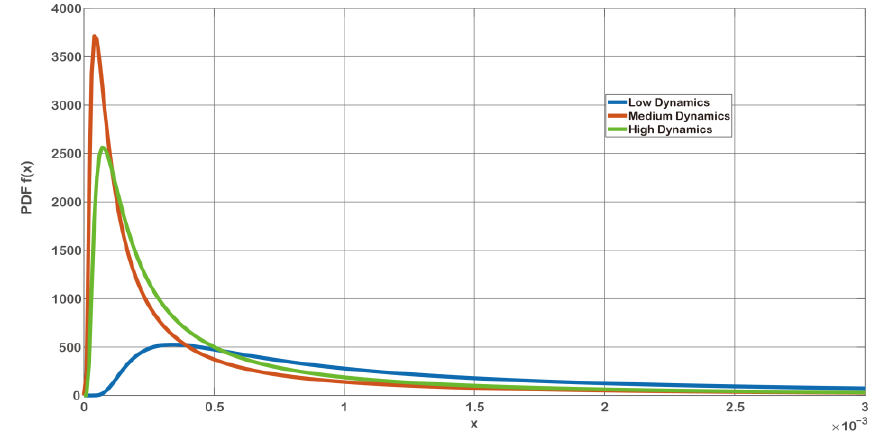
Figure 13. PDF as a function of the CIR attenuation in the case of each link type.